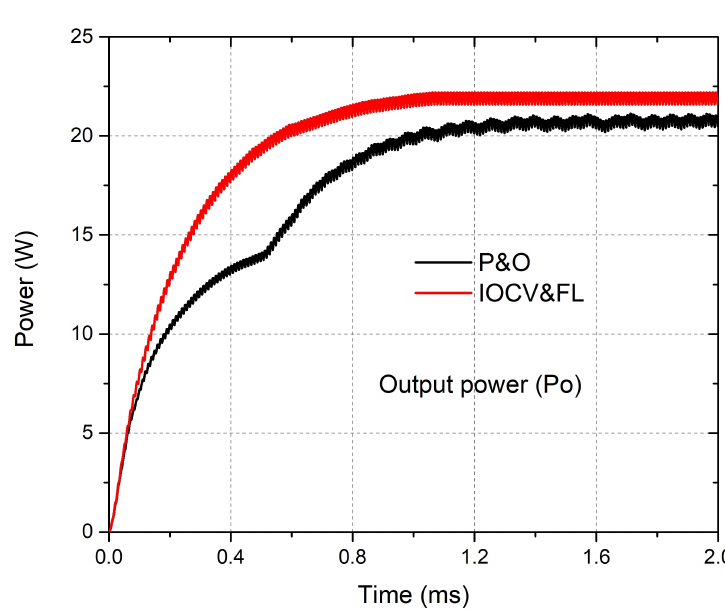
Figure 11. Output power